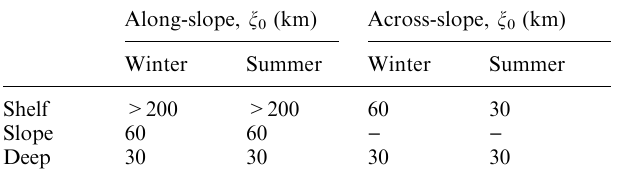
Table 1. Lagrangian correlation time scales, as the first zero crossing s in C ( s ), the Lagrangian velocity correlation time scale 0 Along-slope, s 0